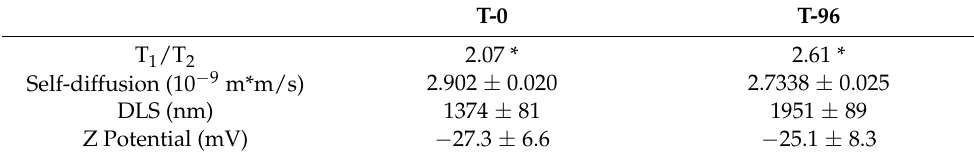
Table 5. Physical–structural properties of non‐heated and heated LSFE+SD.